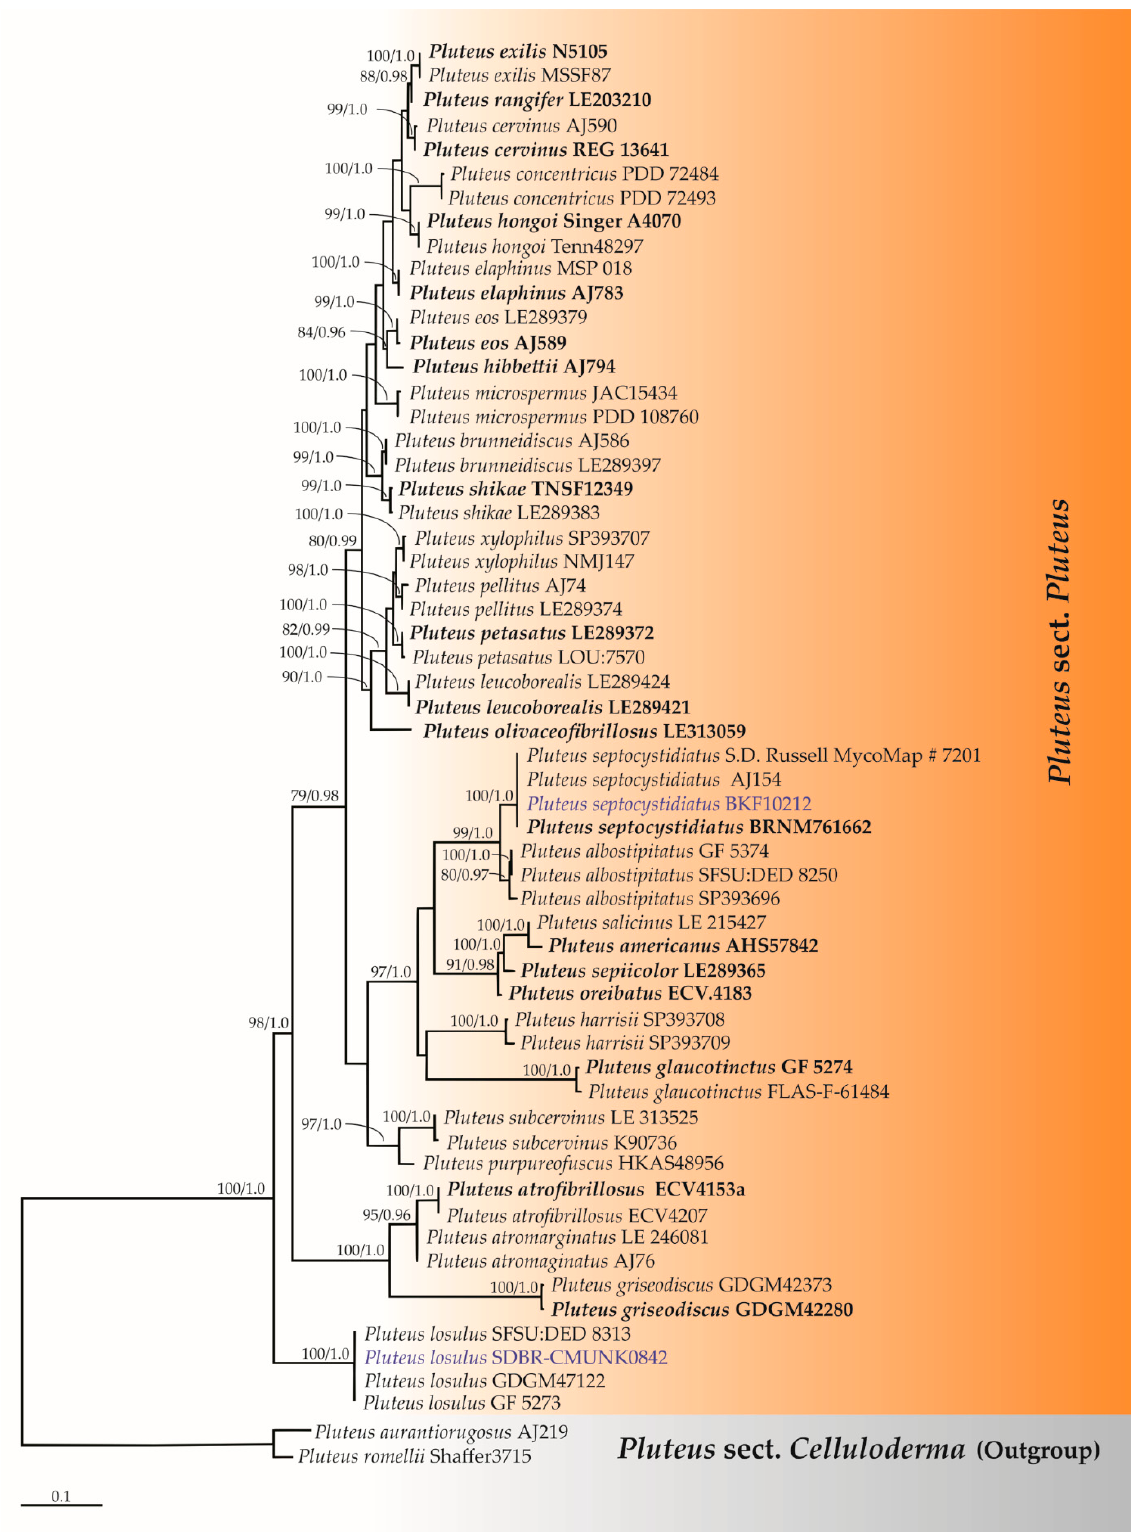
Figure 3. Phylogram derived from maximum likelihood analysis of Pluteus sect. Pluteus consists of 59 taxa of ITS sequences. Pluteus aurantiorugosus and P. romellii were used as the outgroup. The numbers above branches represent bootstrap percentages ( left ) and Bayesian posterior probabilities ( right ). Bootstrap values ≥ 75% and Bayesian posterior probabilities ≥ 0.90 are shown. The scale bar represents the expected number of nucleotide substitutions per site. Sequences obtained from this study are in blue. Type specimens are in bold.